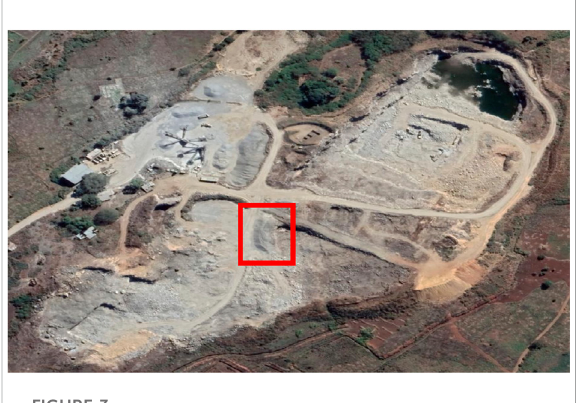
FIGURE 4 DJI Phantom 3 standard